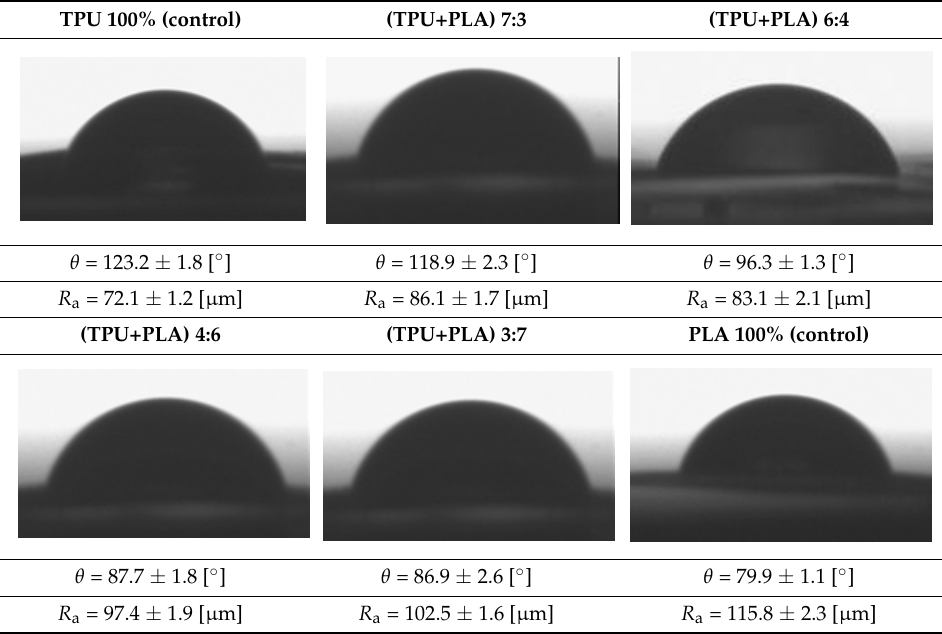
Polymers 2018 , 10 , x FOR PEER REVIEW